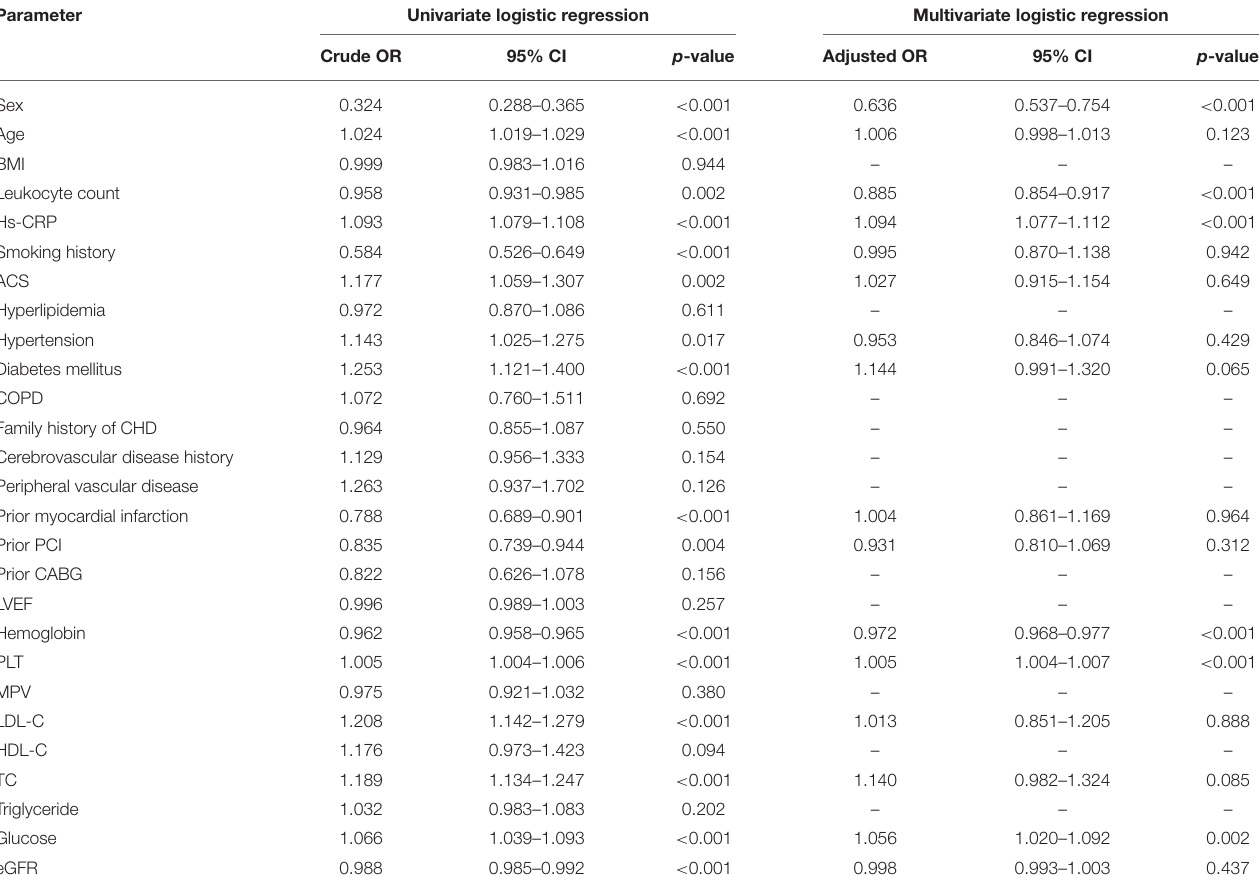
TABLE 3 | Logistic regression for